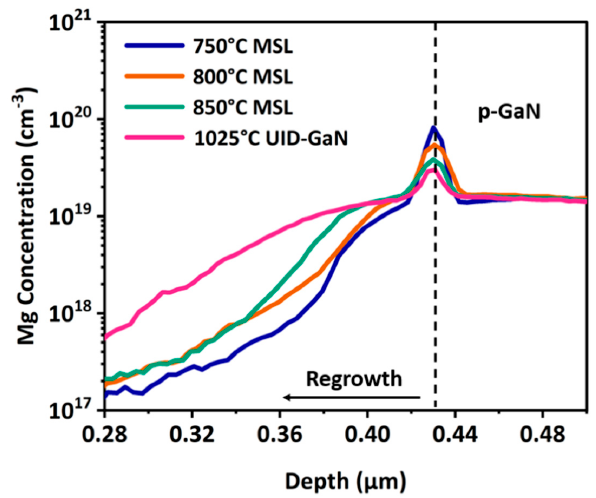
Figure 7. SIMS depth profiles of Mg in four test samples with different regrowth temperatures on p-GaN.